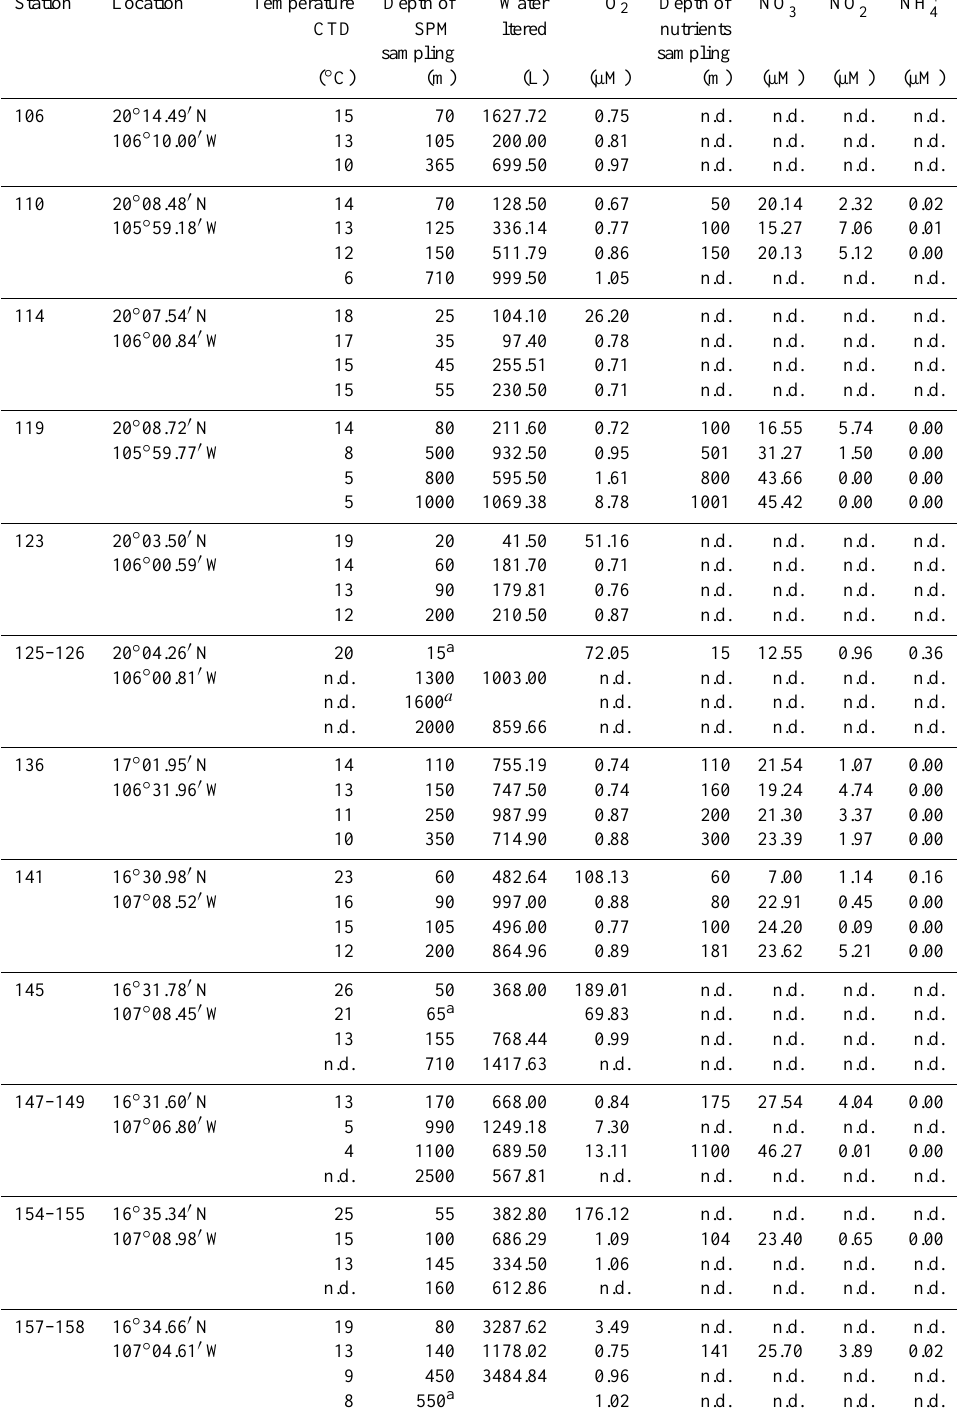
Table 1. Sampling locations for SPM during the eastern tropical North Pacific cruise aboard the R/V Thomas G. Thompson (March– April 2012). For each sampling location the table reports the depth of SPM sampling, the volume of water filtered by each pump deployed, and physical parameters of the water at these depths, i.e., temperature and oxygen concentration (O 2 ). Nutrients concentrations, i.e.,